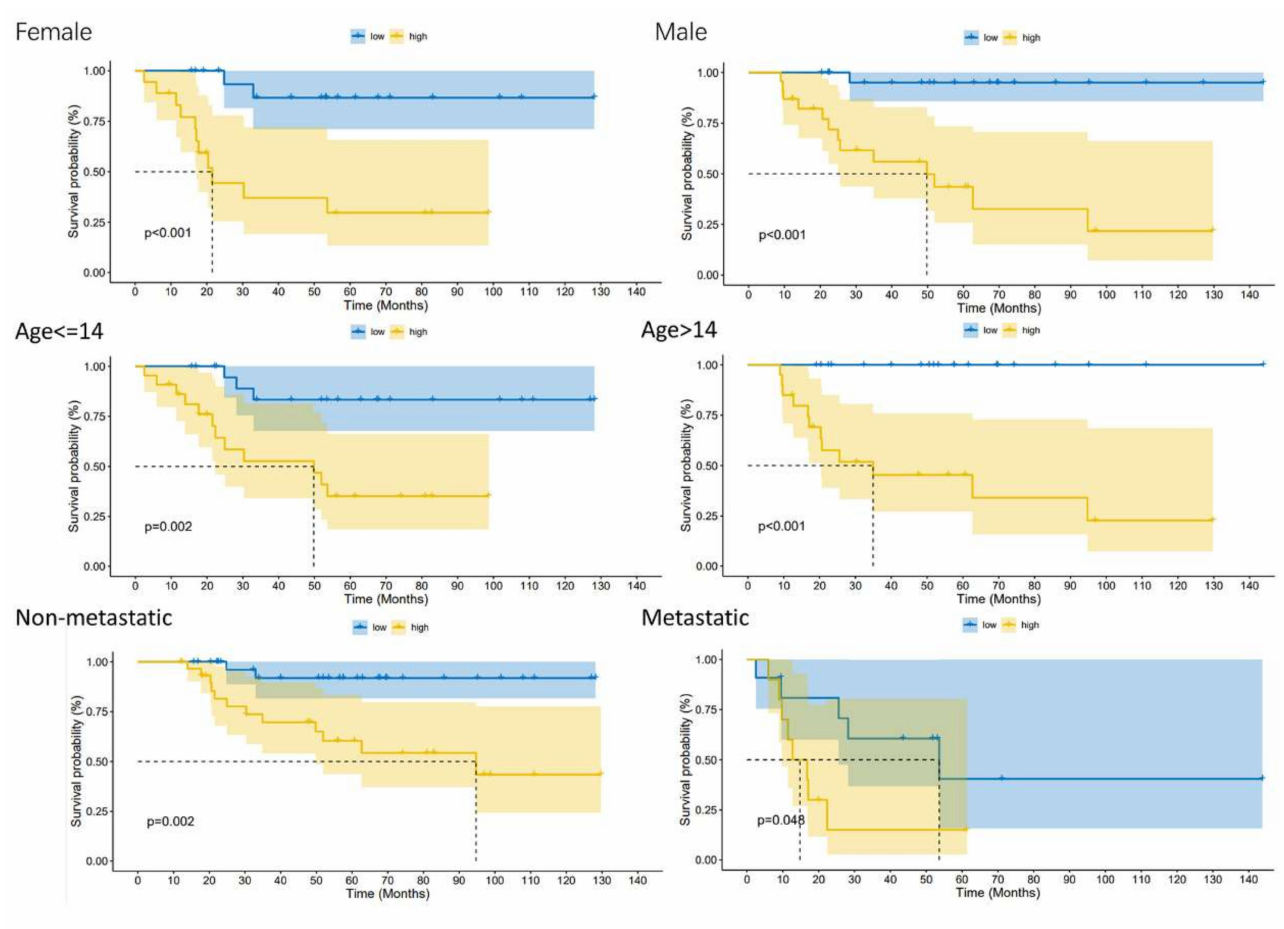
Figure 4. Kaplan–Meier plots depicting subgroup survival analyses stratified by gender, age, and